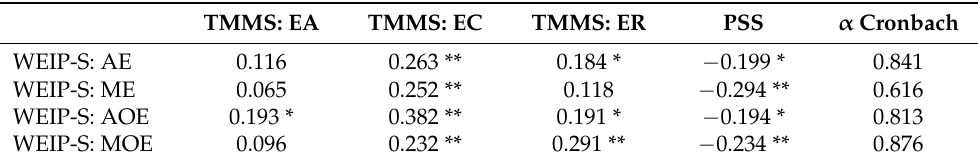
Table 6. Correlation coefficient and Cronbach’s alpha between all WEIP-S scales and the complemen- tary psychological